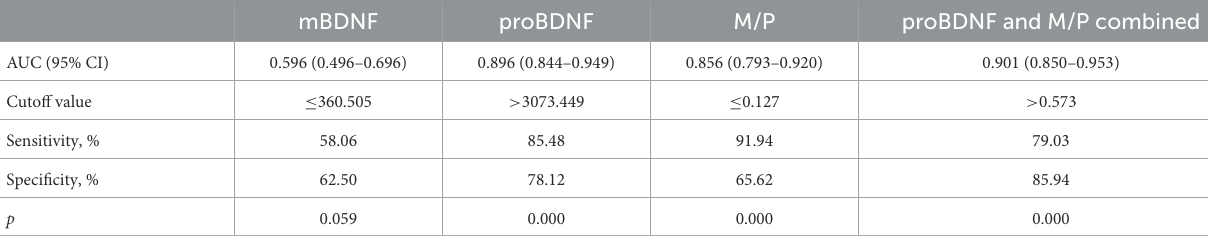
TABLE 4 Diagnostic value of the serum mBDNF levels, proBDNFlevels, and